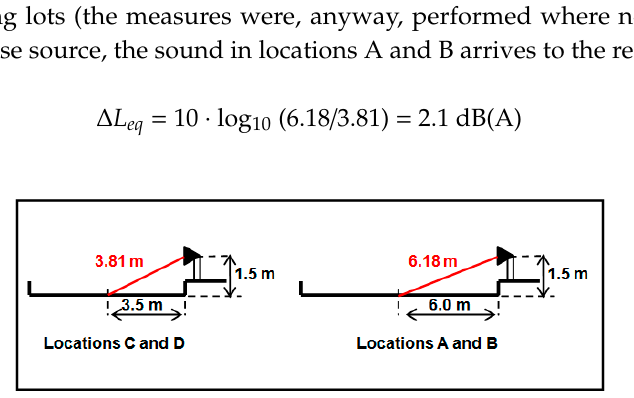
Figure 2. Distances of phonometer from the centre of the road.